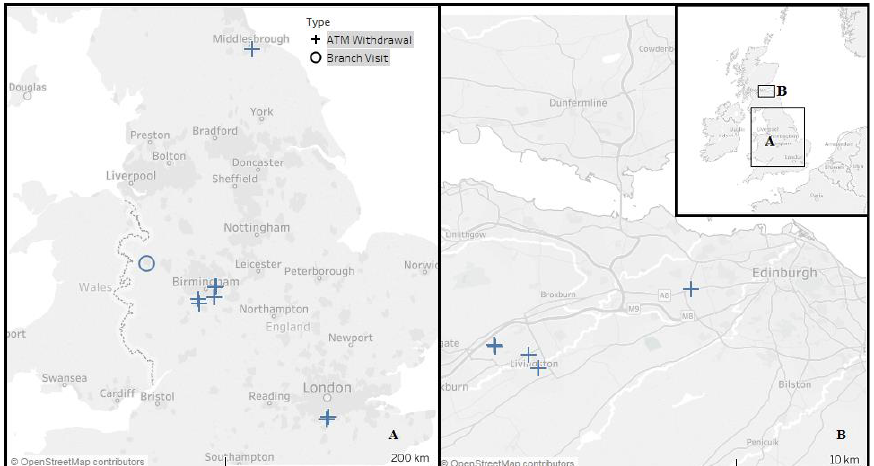
Figure 3. The comparison of locations visited by clients predicted by the described model as anomalous (left) and normal behaviour (right). The scales of maps A and B are